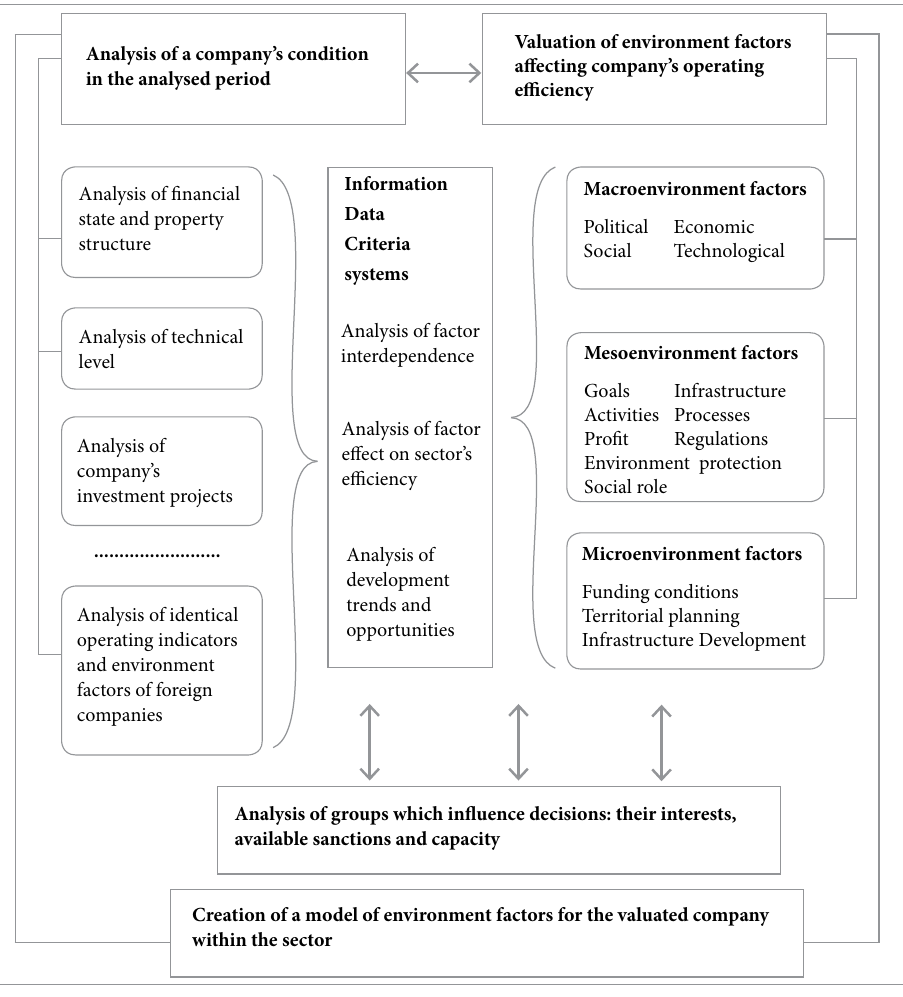
Fig. 1. The theoretical analysis model for environment factors affecting company’s